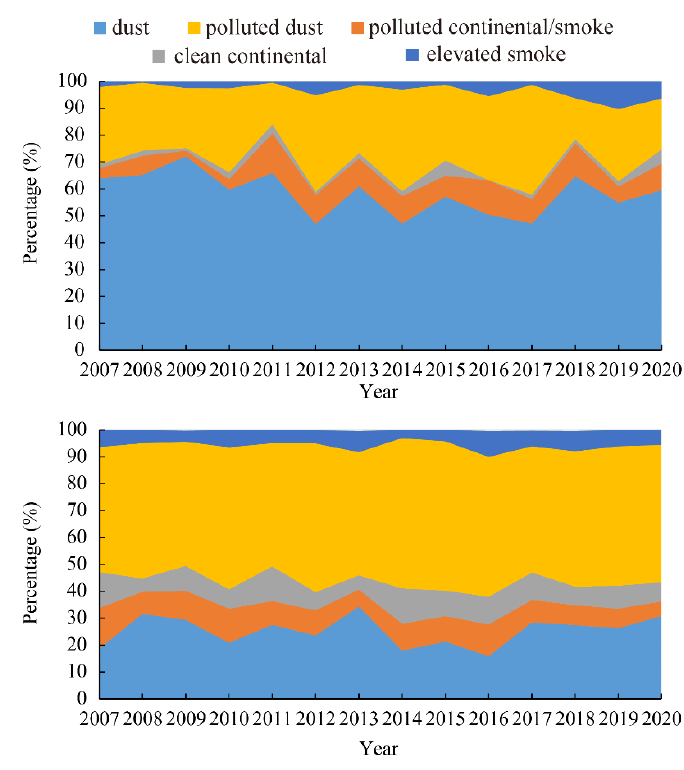
Figure 2. Change in percentage of aerosol subtypes in the daytime (the top panel) and nighttime (the bottom panel) from 2007 to 2020 in the Aral Sea region.